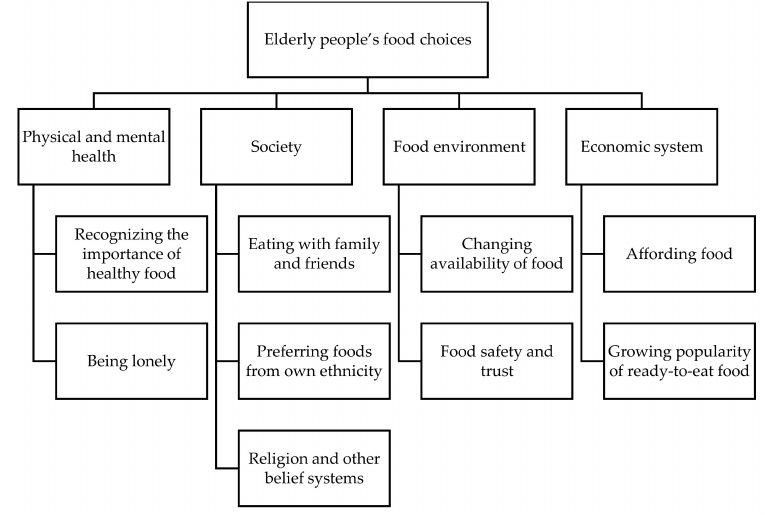
Figure 2. Elderly people’s food choices and dietary practices (adapted from the food choice process